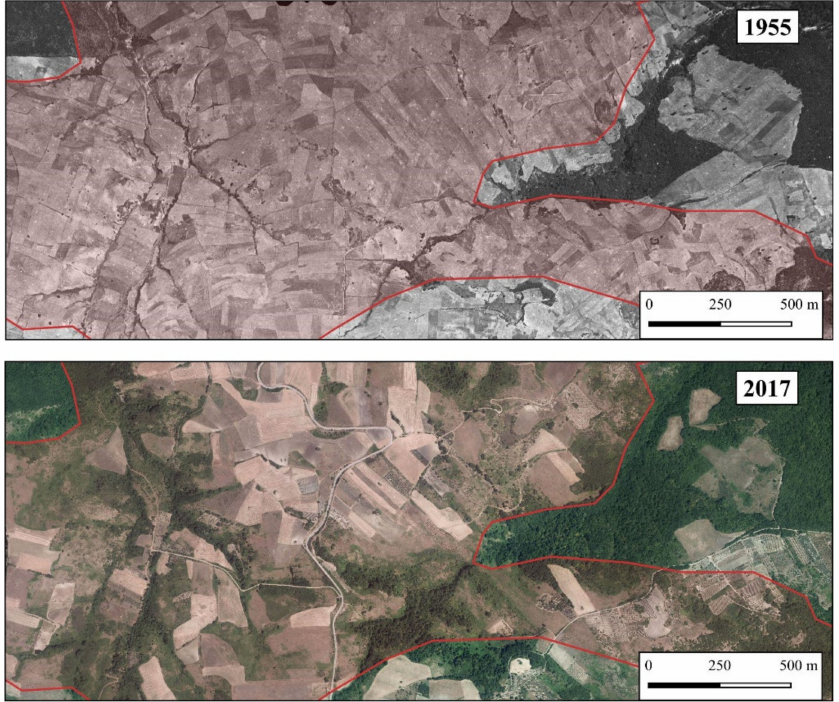
Figure 13. Comparison and verification of reforestation using aerial photos (1955) and digital orthophotos (2017). Red shows forest areas that were cleared in 1950. It can be seen that in 2017 (bottom) the areas have increased and forest recovery is occurring in some of the areas that were forested before